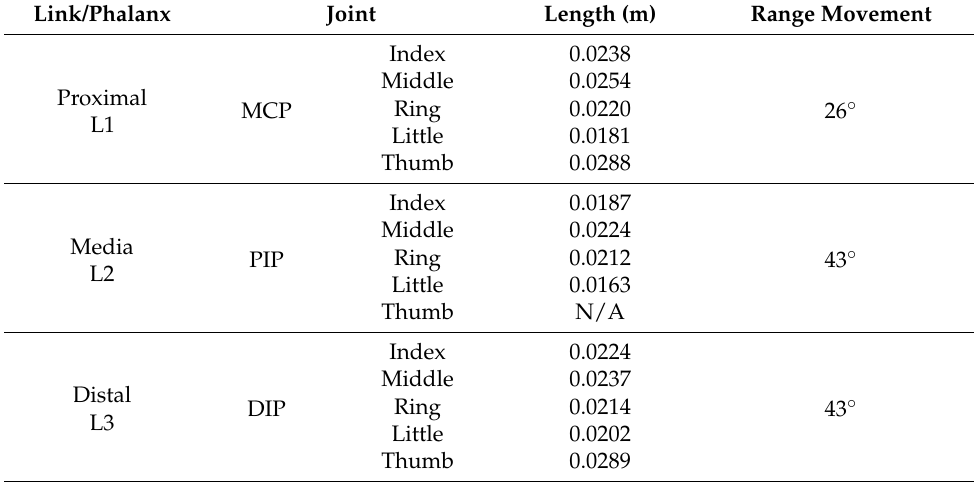
Table 2. Length and range of movements of the hand phalanges